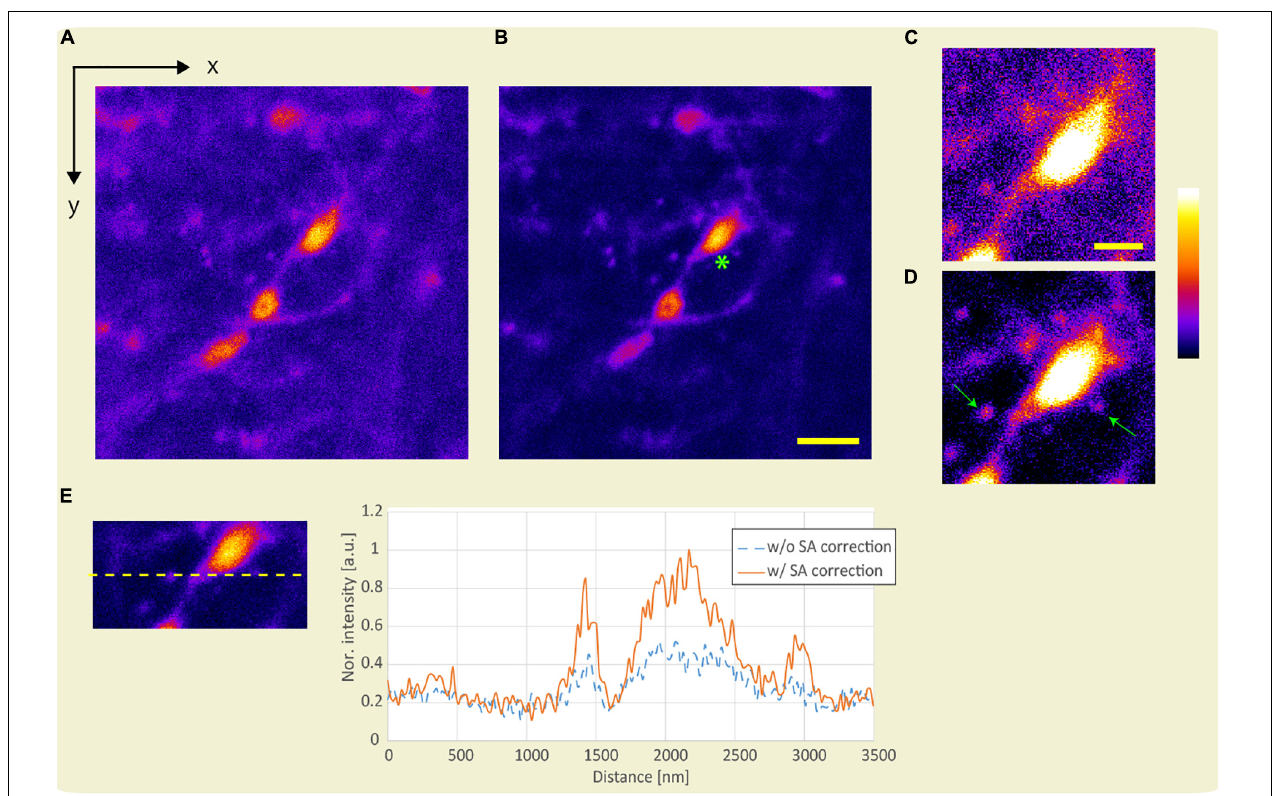
FIGURE 8 | Observation result of the YFP mouse brain at an optical depth of 186.5 µ m. x-y images were obtained using the APV excitation beam (A) without and (B) with SA correction. Scale bar: 5 µ m. (C,D) Magnified view of the area around the green asterisk in panel (B) . Scale bar: 2 µ m. (E) Line profile. The excitation beam intensity under the objective lens is 172